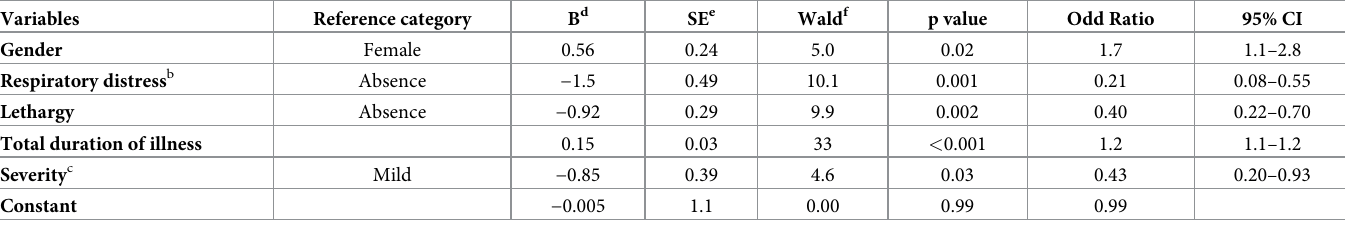
Table 3. Risk factors for post-COVID-19 syndrome (binary logistic regression analysis a